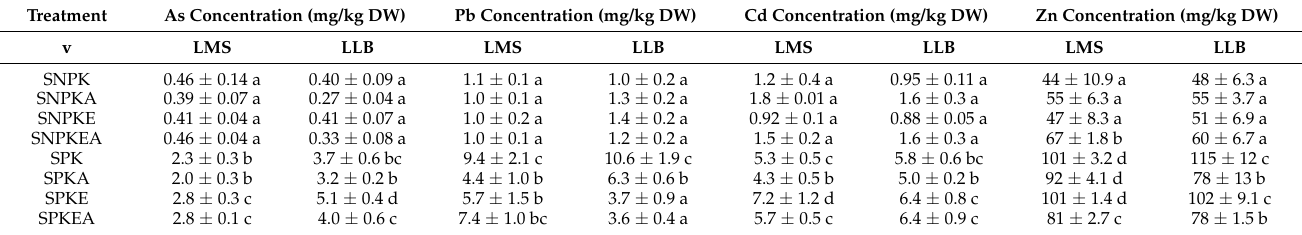
Table 5. Total concentration (mg kg − 1 DW) of heavy metal (As, Pb, Cd, and Zn) in leaf (LMS: leaf on main stem; LLB: leaf on lateral branch) of K. pentacarpos exposed to non-polluted or polluted soil in the presence or in the absence of NaCl or/and EDDS for five months. Each value is the mean of 3 replicates and vertical bars are S.E. Values exhibiting different letters are significantly different at p < 0.05 according to SNK